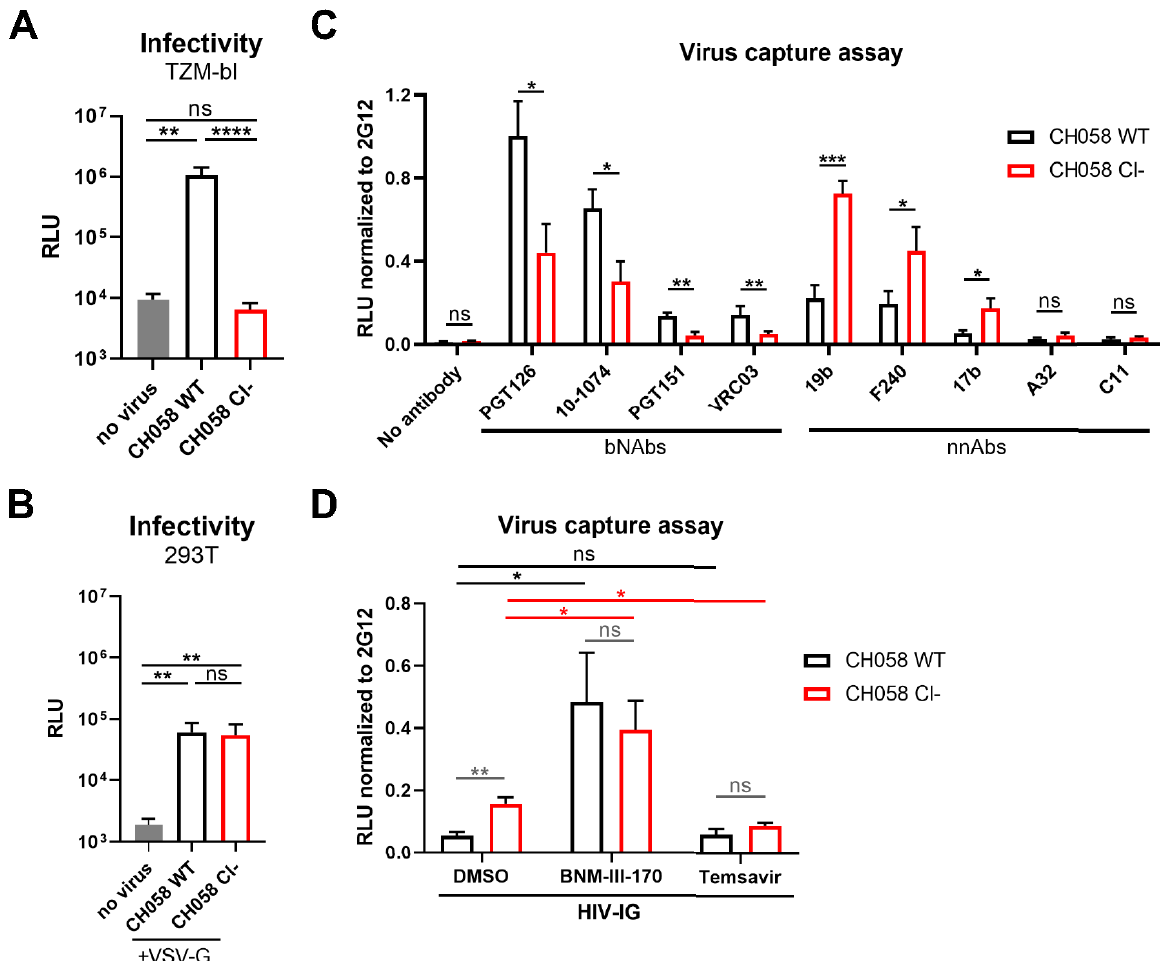
Figure 2. Virions displaying uncleaved Env are better recognized by nnAbs. ( A ) Viral infectivity was assessed by incubating TZM-bl target cells with HIV-1 CH058 virions expressing the wild-type (WT) or cleavage-deficient (Cl − ) Env glycoprotein for 48 h. Viral preparations were normalized according to reverse transcriptase activity. ( B ) VSV-G-pseudotyped viral particles encoding the luciferase gene (Luc+) and bearing HIV-1 CH058 Env wildtype (WT) or its cleavage-deficient mutant (Cl − ) were used to infect 293T cells to determine their infectivity in a single-round infection. ( C , D ) These recombinant pseudovirions were further tested for virus capture by ( C ) a panel of anti-Env bNAbs (PGT126, PG9, PGT151, VRC34, VRC03) and nnAbs (19b, F240, 17b, A32, C11) or ( D ) HIV-IG. RLU values obtained using the different antibodies were normalized to the signal obtained with the conformation-independent 2G12 mAb. Data shown are the mean ± SEM from at least three independent experiments. Statistical significance was tested using an unpaired t -test or a Mann–Whitney U -test based on statistical normality (* p < 0.05; ** p < 0.01; *** p < 0.001; **** p < 0.0001; ns, nonsignificant).